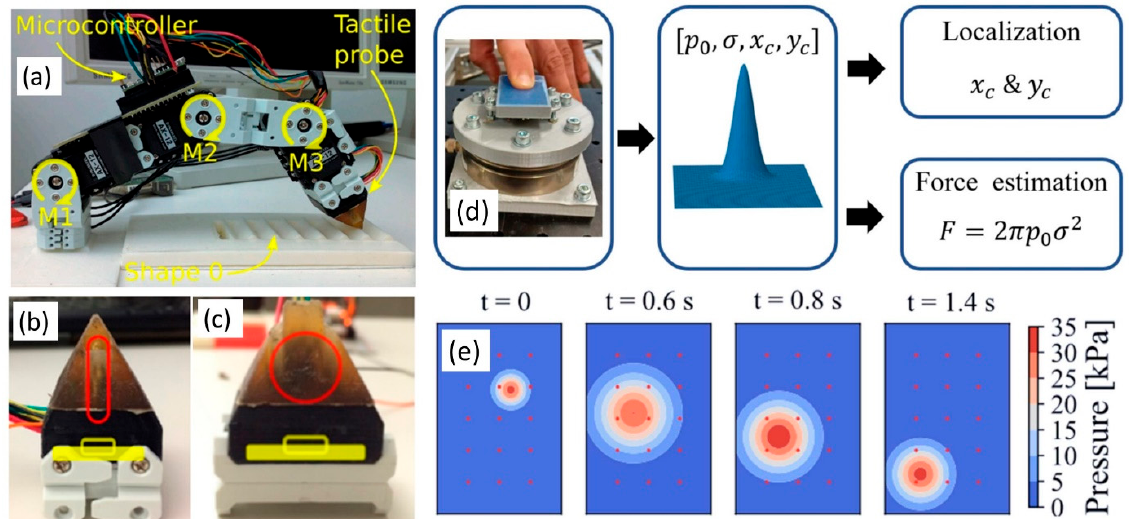
Figure 7. Experimental setup: ( a ) Robot finger composed of three motors: M1 is the “bottom” motor; M2 is the “middle” motor; and M3 is the “top” motor. The microcontroller is attached on top of Motors M1 and M2. ( b ) Front view of the tactile probe: the MARG system is embedded under the red circle; the pressure sensor is under the yellow overlay in the black 3D printed collar. ( c ) Side view of the tactile probe. Reprinted/adapted with permission from Ref. [62]. Copyright 2017, MDPI. ( d ) Illustration of the working principle of the model-based simultaneous localization and force estimation. Left: Finger creates contact with the sensor. Middle: Optimization finds parameter values of the parameterized Gaussian pressure distribution that best fits the pressure data. Right: The found parameters values are used to simultaneously locate the contact and estimate forces. Reprinted/adapted with permission from Ref. [63]. Copyright 2022, IEEE. ( e ) Reconstructed pressure distribution during the slip experiment on the tactile sensor. Reprinted/adapted with permission from Ref. [62]. Copyright 2017, MDPI.